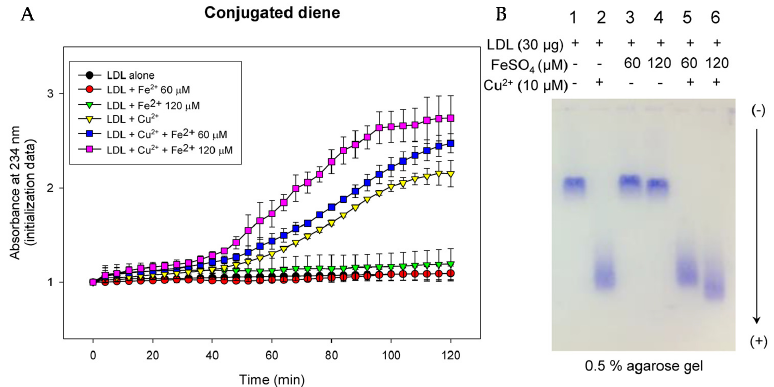
Figure 4. Oxidation of low ‐ density lipoprotein (LDL) by Fe 2+ and Cu 2+ . ( A ) Detection of conjugated diene based on absorbance at 234 nm from oxidation; ( B ) Comparison of relative electrophoretic mobility between LDL samples after Fe 2+ and Cu 2+ ‐ mediated oxidation. More ‐ oxidized LDL migrates faster toward cathode in bottom of gel (0.5% agarose).